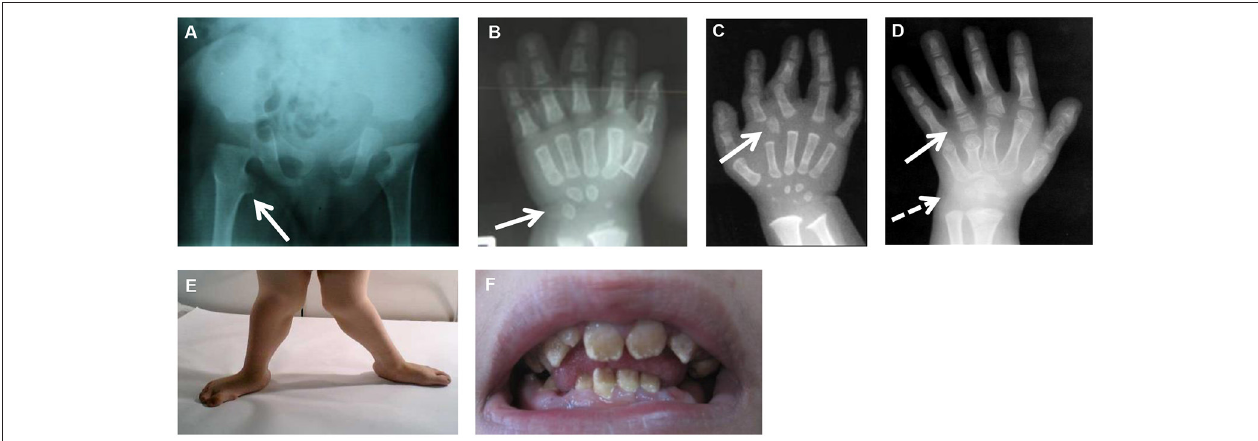
FIGURE 1 | Common and specific clinical features in CMD. (A) Hip X-rays showing a monkey wrench appearance of femur (see arrow). (B) Hand X-rays of a patient with XYLT1 mutations at 8 months of age showing advanced carpal ossification (see arrow). (C) Hand X-rays of a patient with CANT1 mutations at 1 year of age showing presence of a delta phalanx (see arrow). (D) Hand X-rays of a patient with IMPAD1 mutations at 5 years of age showing presence of hyperphalangy (see plain arrow) and carpal synostosis (see dashed arrow). (E) Genu valgum due to joint laxity. (F) Amelogenesis imperfecta in a patient with SLC10A7